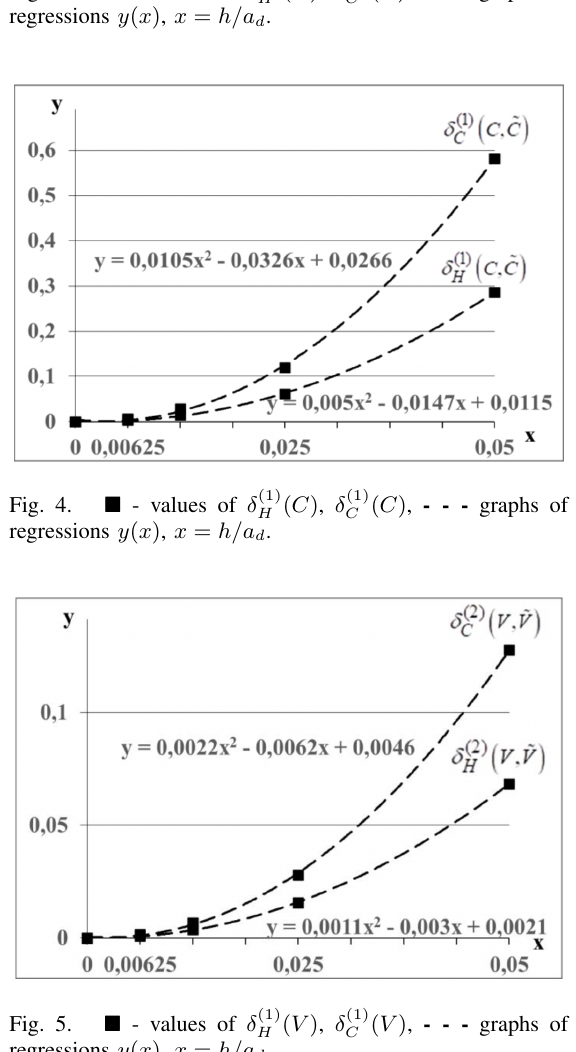
Fig. 5. (cid:4) - values of δ (1) regressions y ( x ) , x = h/a d .